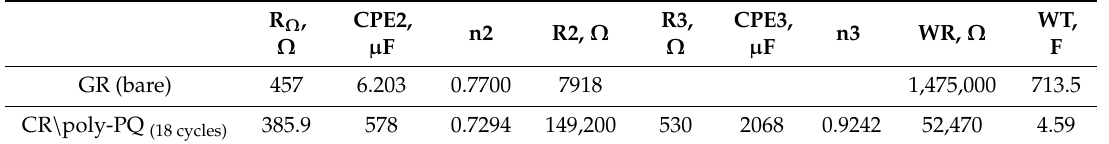
Table 2. Equivalent circuit element values of bare and poly-PQ modified graphite electrodes in A-PBS, pH